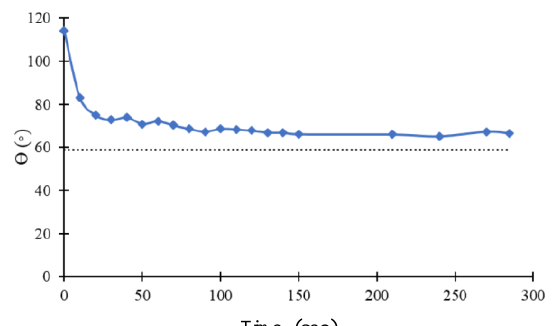
Figure 6. Variation, with time, of the contact angle of a drop of water onto the surface of double scale